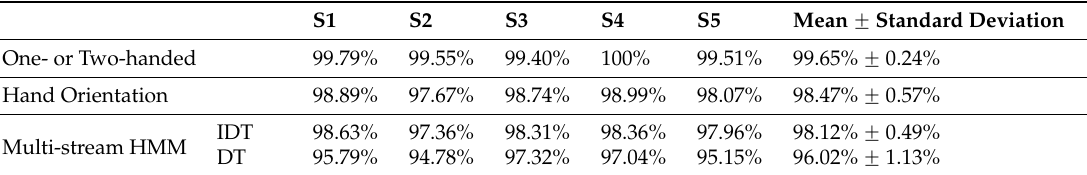
Table 1. Recognition results of sub-classifiers of the improved decision tree and decision tree.